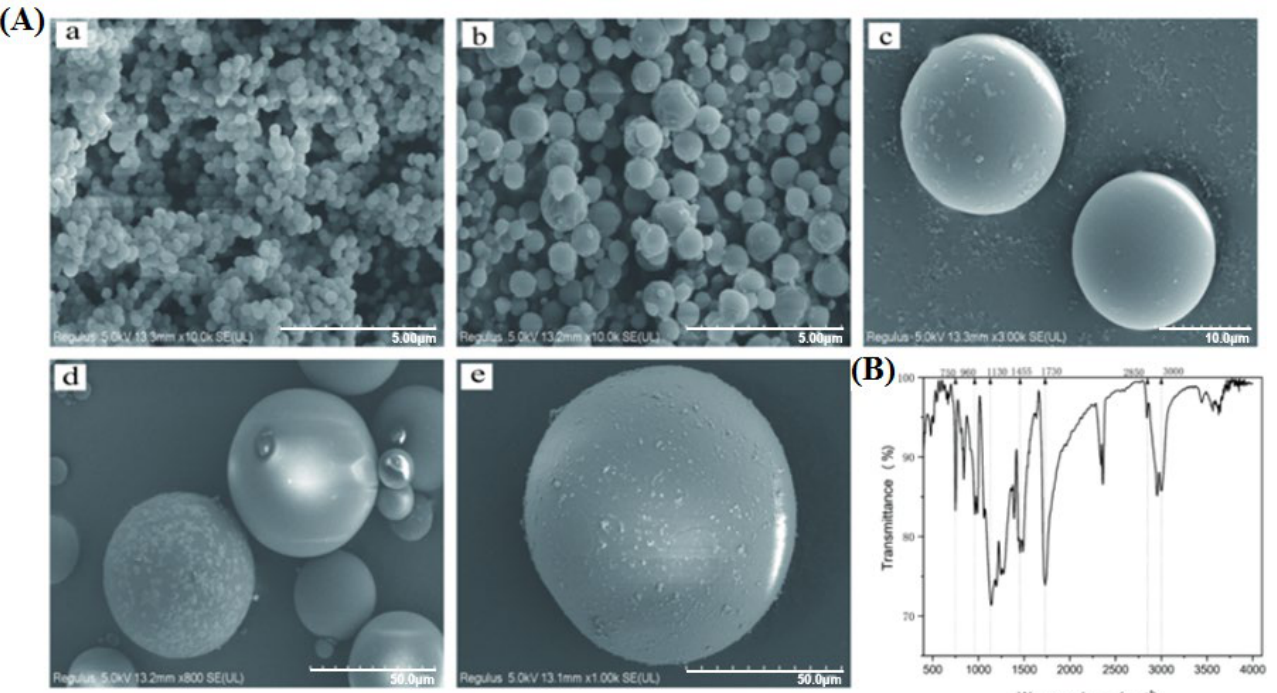
Figure 1. Characterization of PS − MPs used in this study. ( A ) SEM images of PS − MPs with different particle sizes: 0.1 µ m ( a ); 1 µ m ( b ); 10 µ m ( c ); 50 µ m ( d ); 100 µ m ( e ). ( B ) FTIR spectra of PS − MPs. Table 1. Surface area, total pore volume, and average pore diameter of PS-MPs.